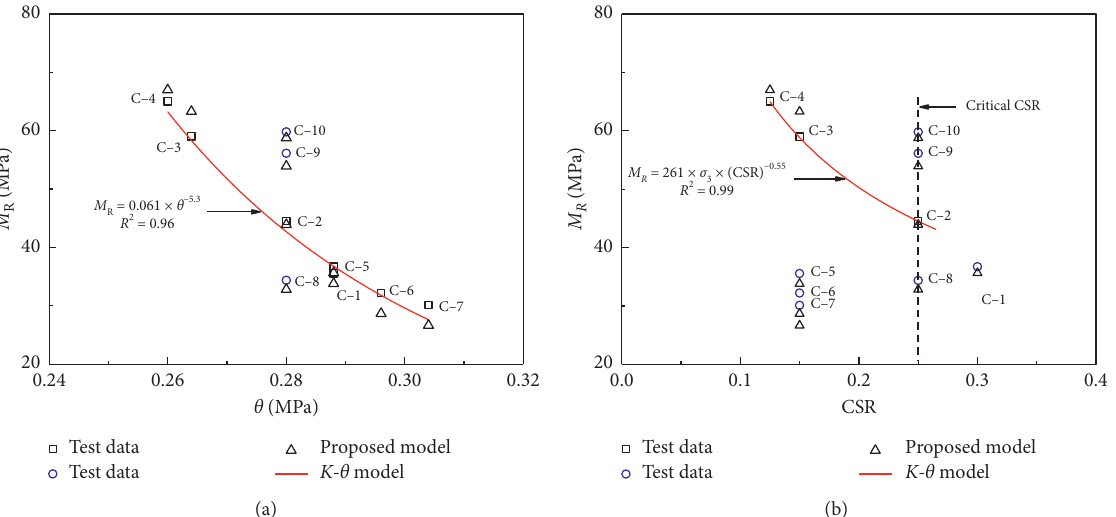
Figure 16: Comparisons between different models: (a) K - θ model; (b) the Guo